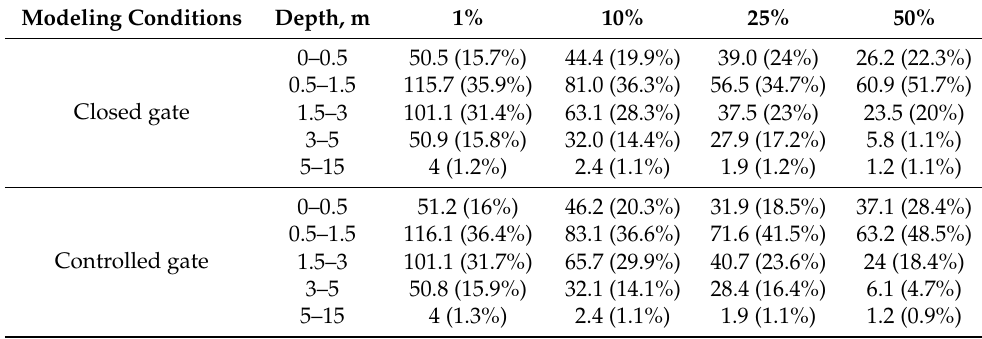
Table 6. Areas covered by different maximum flood depths at different scenarios modelled on modified